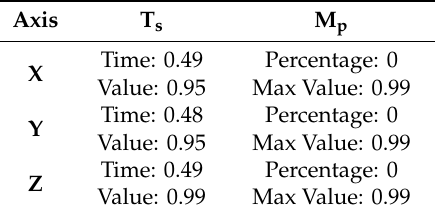
Table 3. Numeric results for step response.